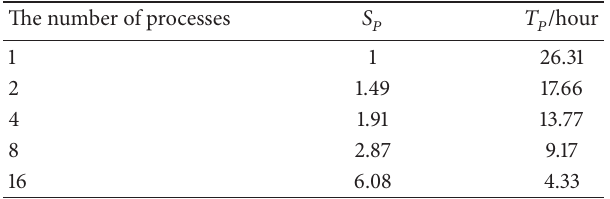
Table 3: Comparison study of results of parallel calculation in different